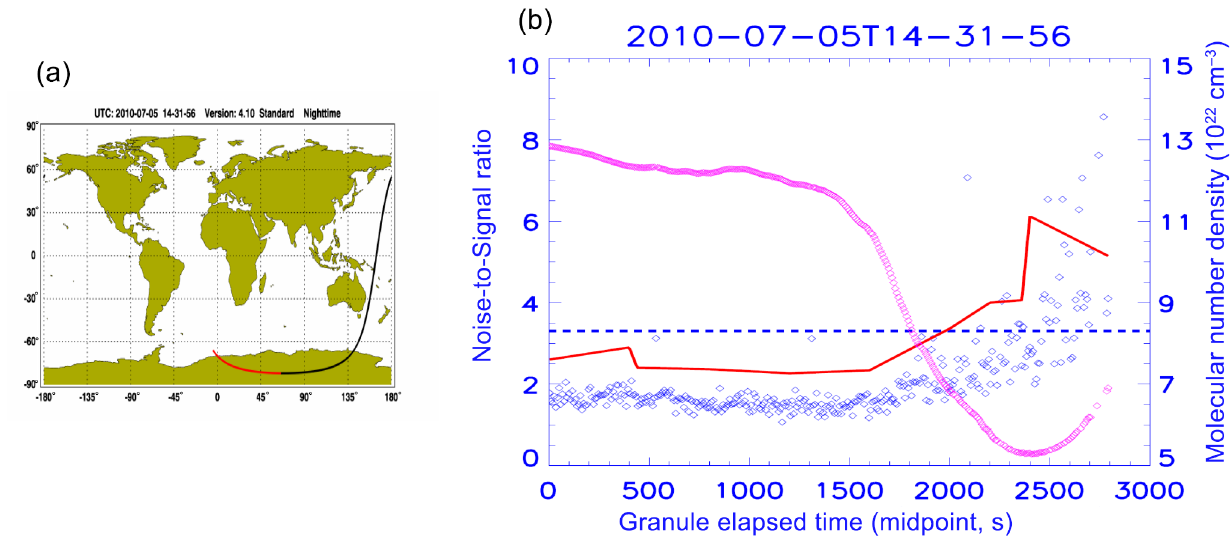
Figure 6. Noise-to-signal ratio (blue diamonds) for a single granule (orbit track shown in a ) showing the effect of V3 (blue dashed line) and V4 (red line) thresholds. Also plotted are the molecular number densities, averaged over 36–39km, along the orbit (in magenta). Extreme outliers beyond NSR of 10 and negative values have not been plotted. The granule elapsed time starts at the day-to-night terminator in the Northern Hemisphere.